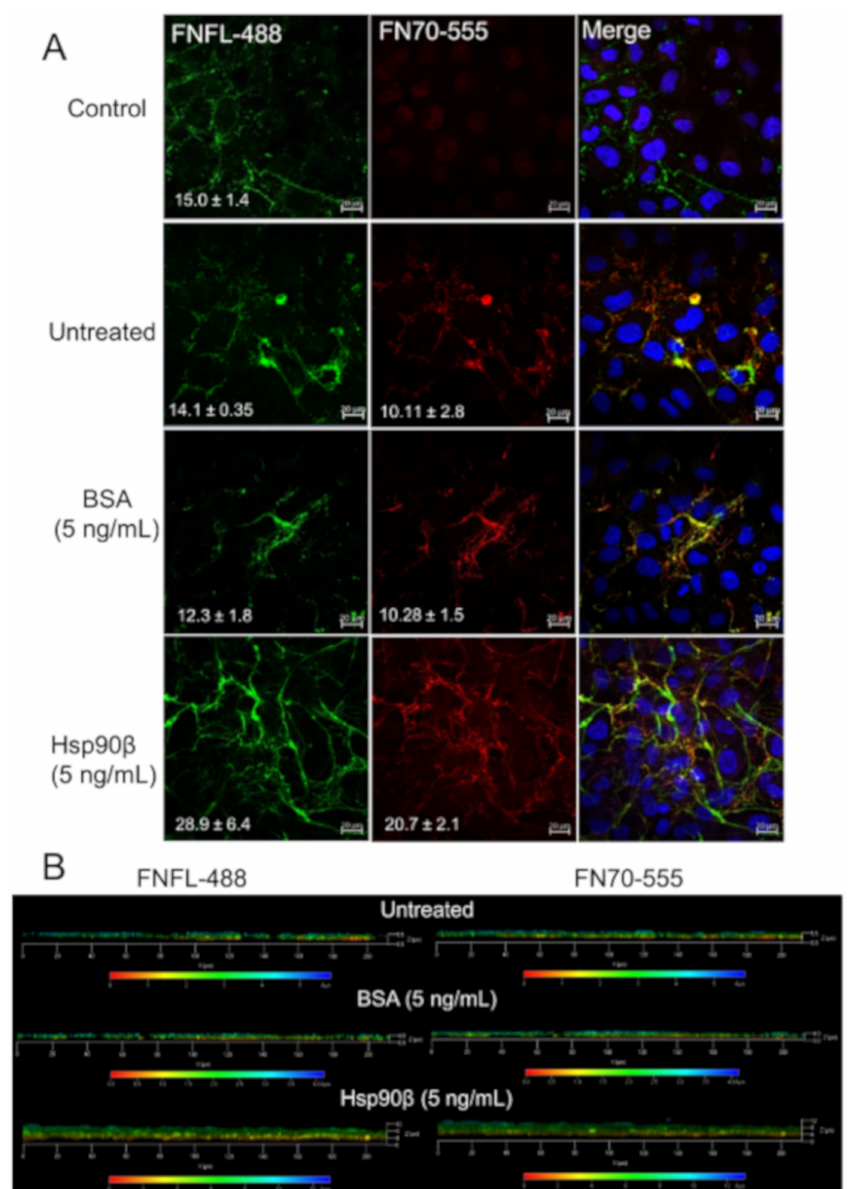
Figure 10. HSP90 treatment increases the incorporation of exogenous FN into fibrils. ( A ) Incorporation of exogenous fluorescently labeled FN into the matrix of Hs578T breast carcinoma cells. Images were captured on a Zeiss LSM 780 laser scanning confocal microscope and analyzed using the Zen Blue software (Zeiss, Germany). Data are representative of triplicate independent studies. Scale bars represent 10 µ m. ( B ) Depth coding of representative 3-dimensional z-stack projections of matrices. Scale bar shown below is color-coded to indicate the depths of matrices in µ